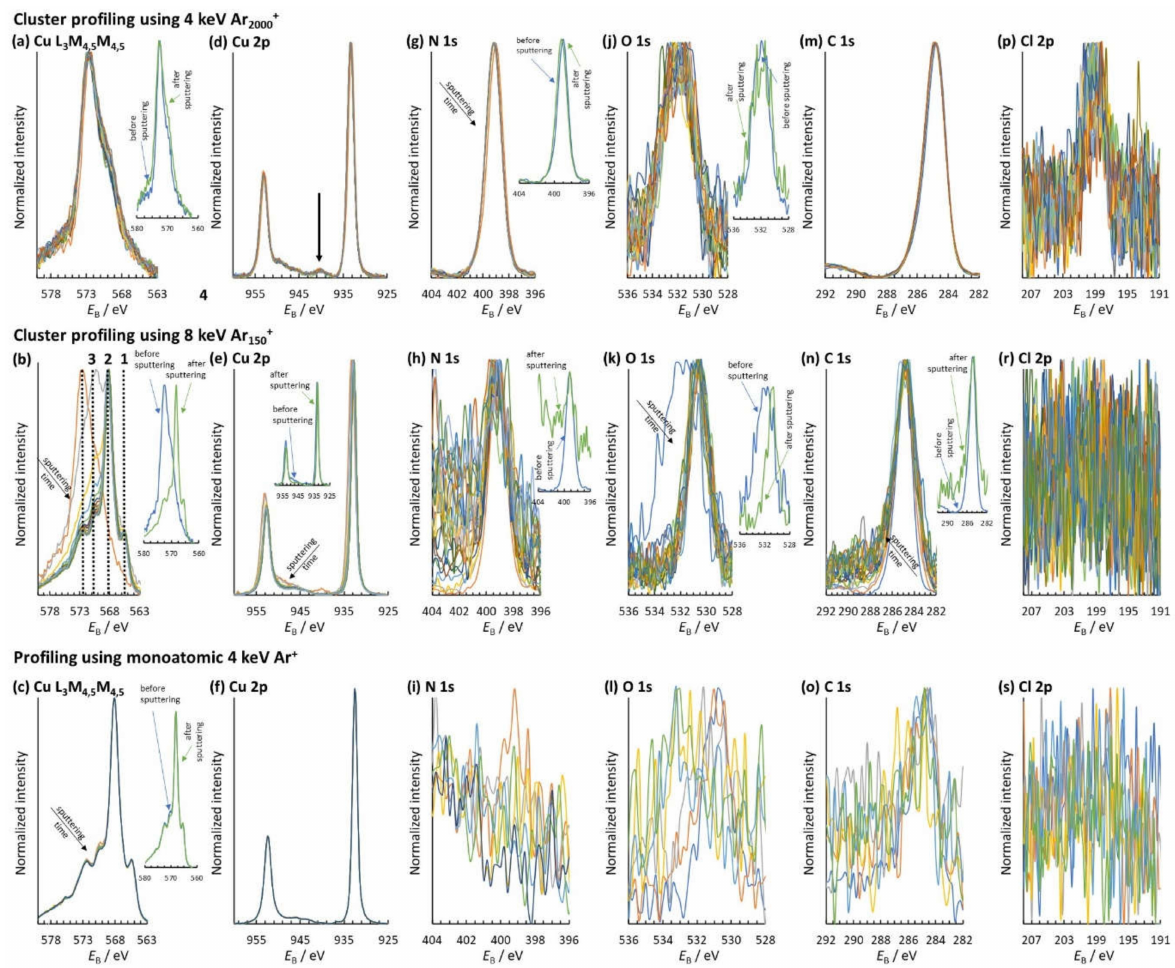
Figure 2. XPS analyses for the 2PhI-treated Cu: HR XPS spectra for ( a – c ) XPS-exited Auger Cu L 3 M 4,5 M 4,5 , ( d – f ) Cu 2p 3/2 ,